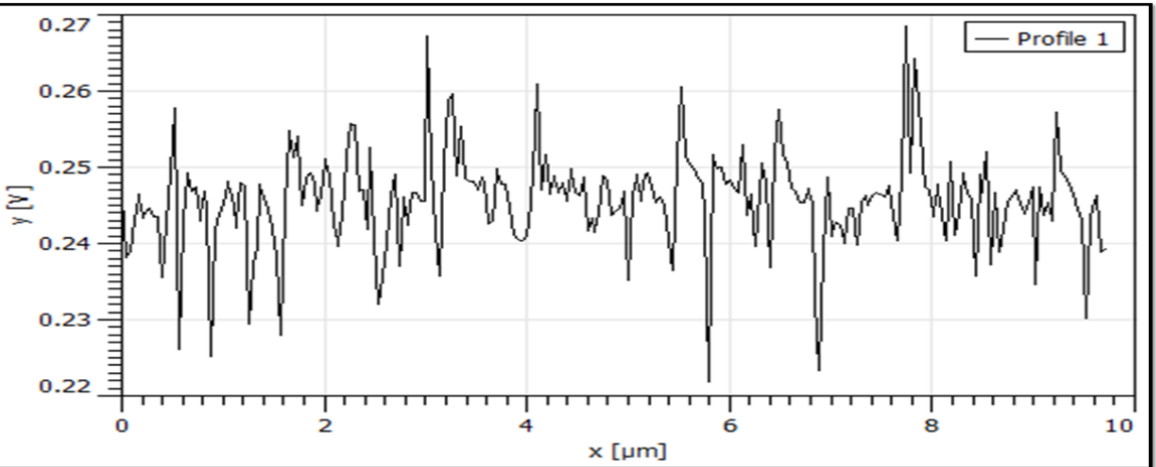
Figure 11. Line scan (small portion) of AFM data of the CN-6 sample to determine the diameter of the nanocrystals.